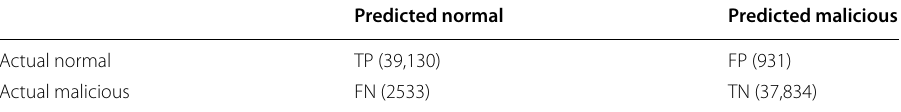
Table 10 Confusion matrix of ANN